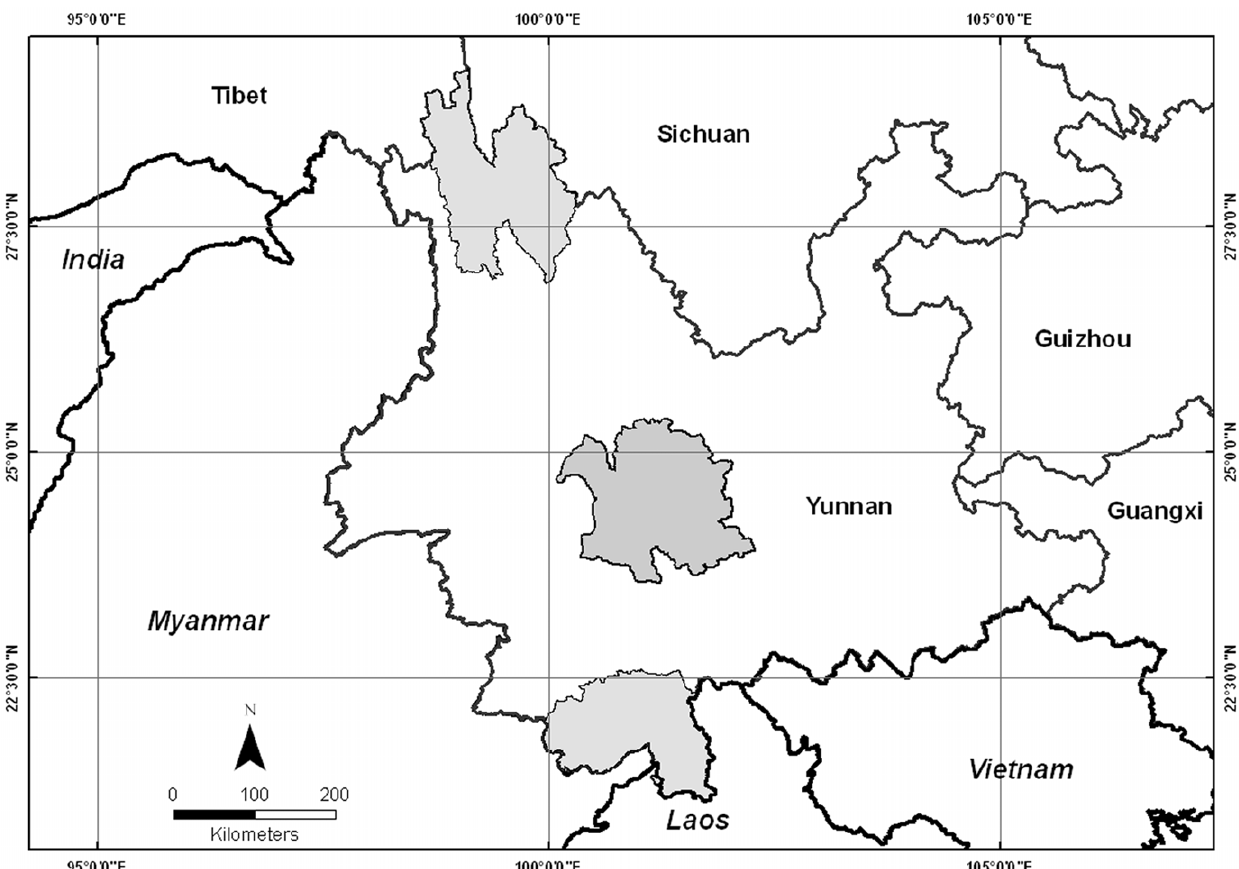
Figure 1. Map showing the study areas: Northwestern, Central and Southern Yunnan.